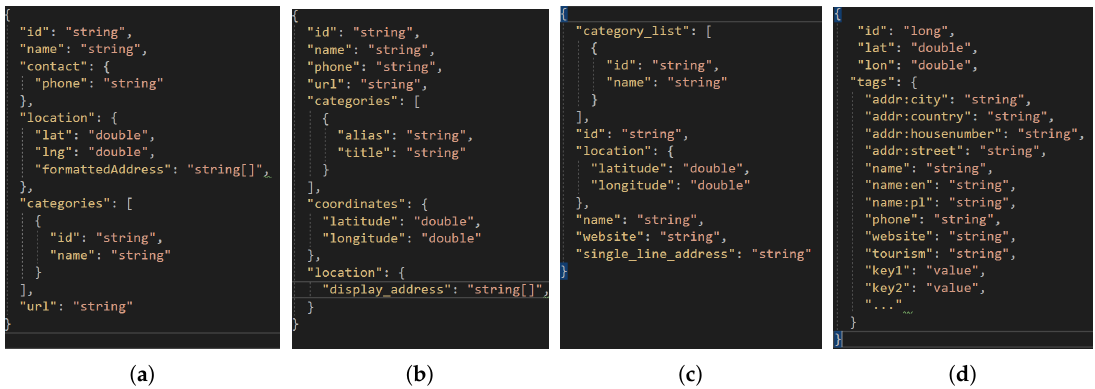
Figure 1. The JSON-structured (parts of) Point of Interest models of: FourSquare ( a ); Yelp ( b ); Facebook Places ( c ); and OpenStreetMap ( d